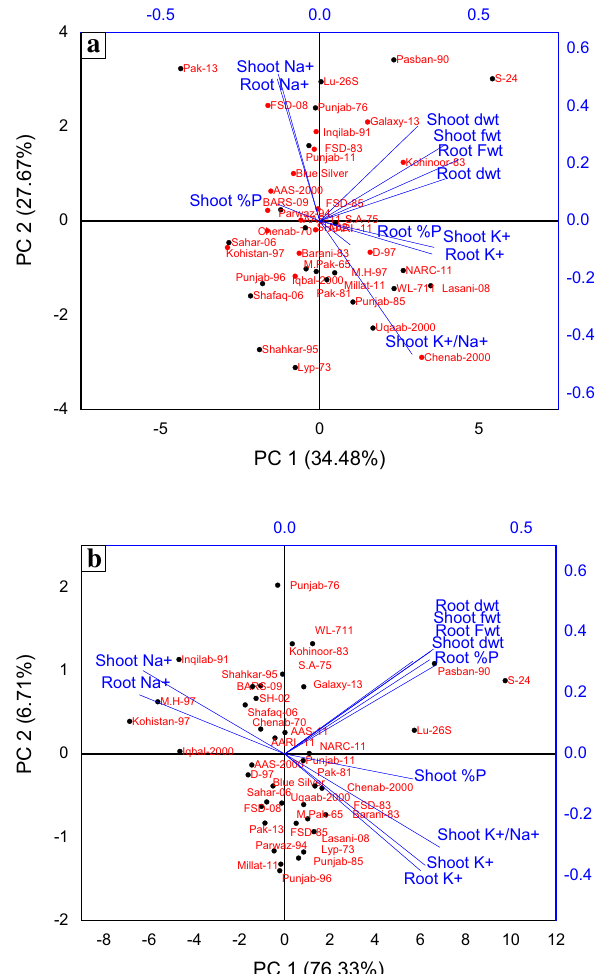
Figure 1. Biplots of PCA for different parameters to screen 40 wheat cultivars at seedling stage under ( a ) Control conditions ( b ) Saline conditions.